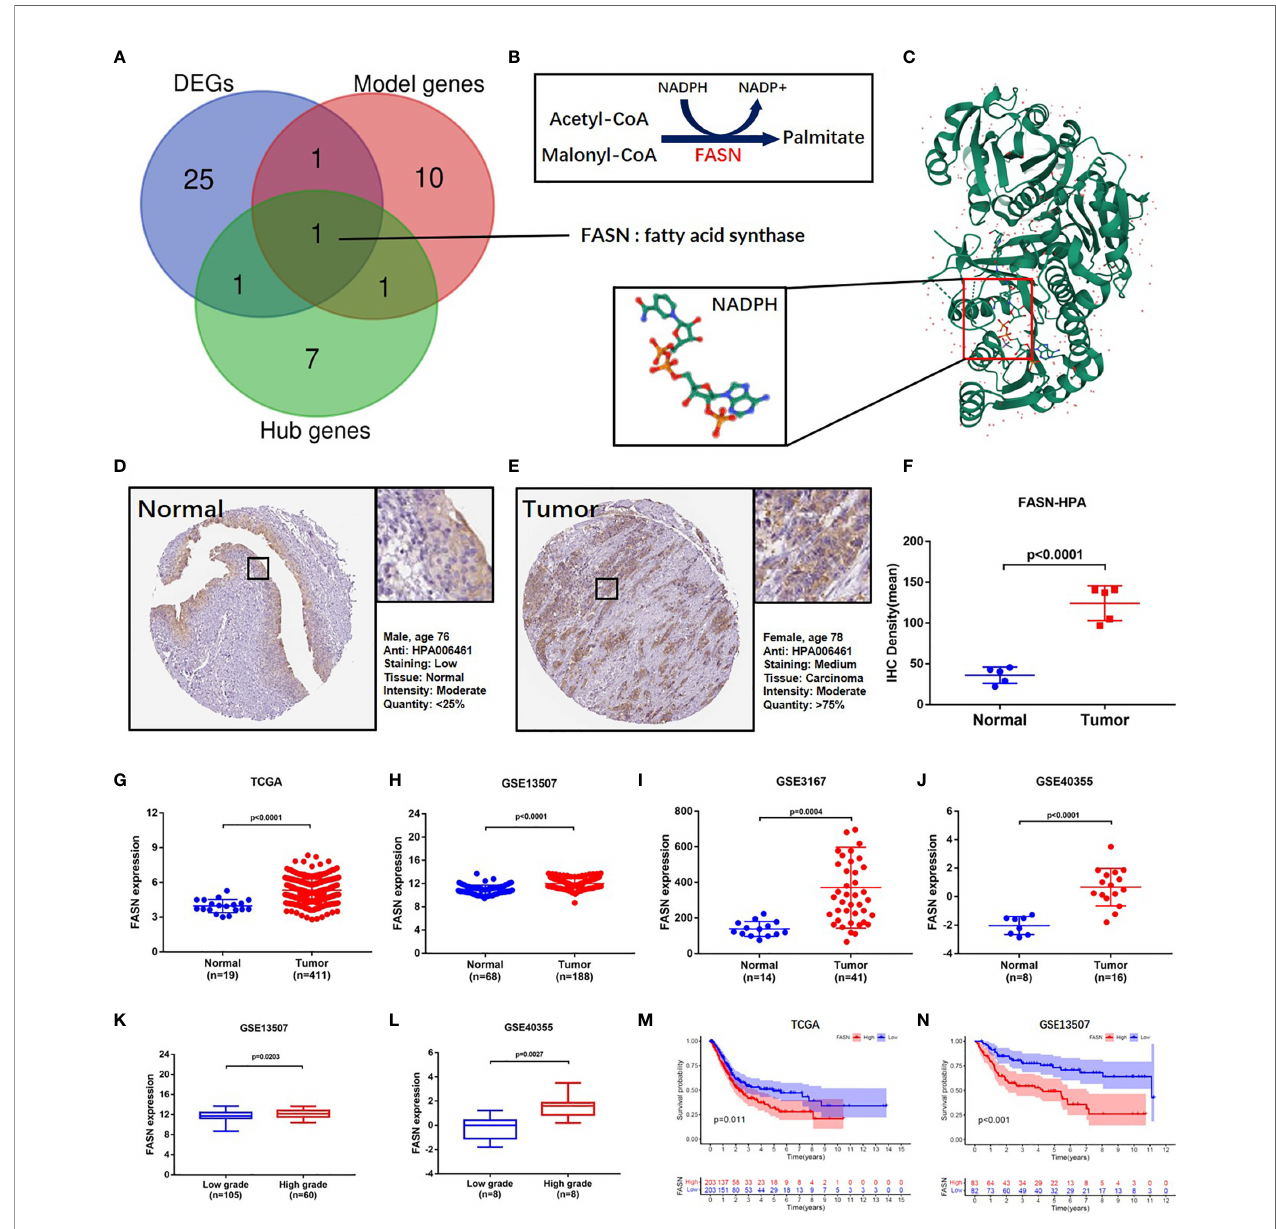
FIGURE 2 | Identi fi cation and validation of FASN. (A) Venn diagram of the top 10 PPI hub genes, 52 differentially expressed genes and 13 model genes. (B) Mechanism diagram of the role of FASN in fatty acid metabolism. (C) 3D structure of the protein translated by FASN and NADPH ligand from the PDB database. (D – F) IHC staining of FASN in tumor and normal tissues of BC patients from the HPA database. (G – J) Differential expression of FASN between the tumor and normal groups in TAGA, GSE13507, GSE3167 and GSE40355. (K, L) Differential expression of FASN between low- and high-grade patients in GSE13507 and GSE40355. (M, N) Overall survival probability between the low- and high-FASN groups in TCGA and GSE13507 (patients grouped by median